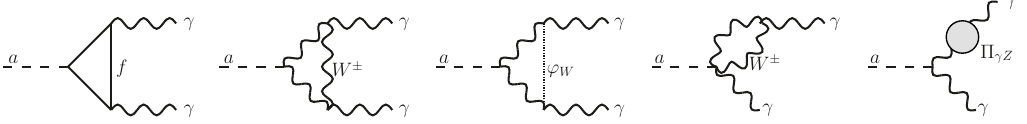
Figure 1 . Representative one-loop Feynman diagrams contributing to the decay a internal boson lines represent charged W bosons and the associated charged Goldstone (cid:12)elds. The last diagram contains the (gauge-dependent) self-energy (cid:5) (cid:13)Z (0). One also needs to include the on-shell wave-function renormalization factors for the external photon